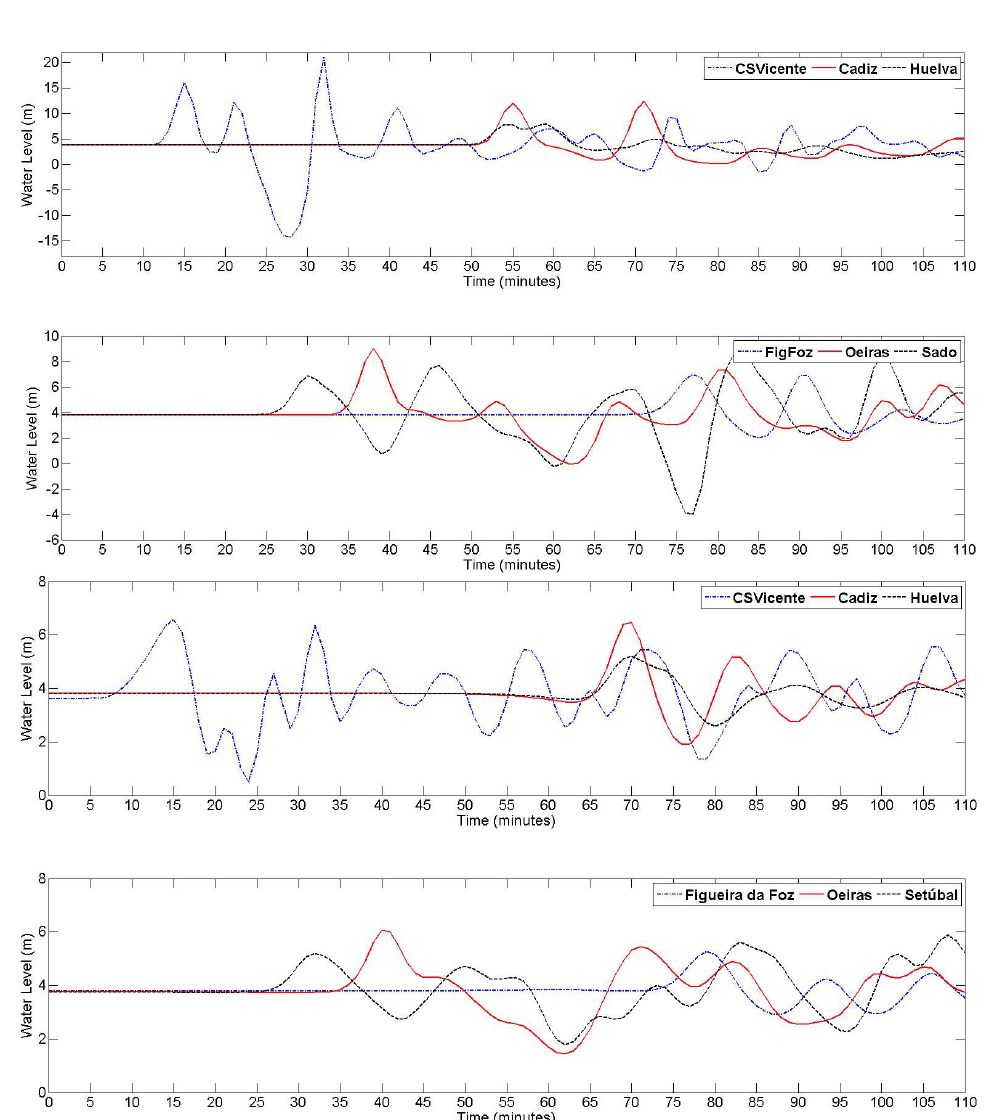
Fig. 4. Top: time series for source (a) , Middle: time series source (b) , Bottom: time series for source (c) .